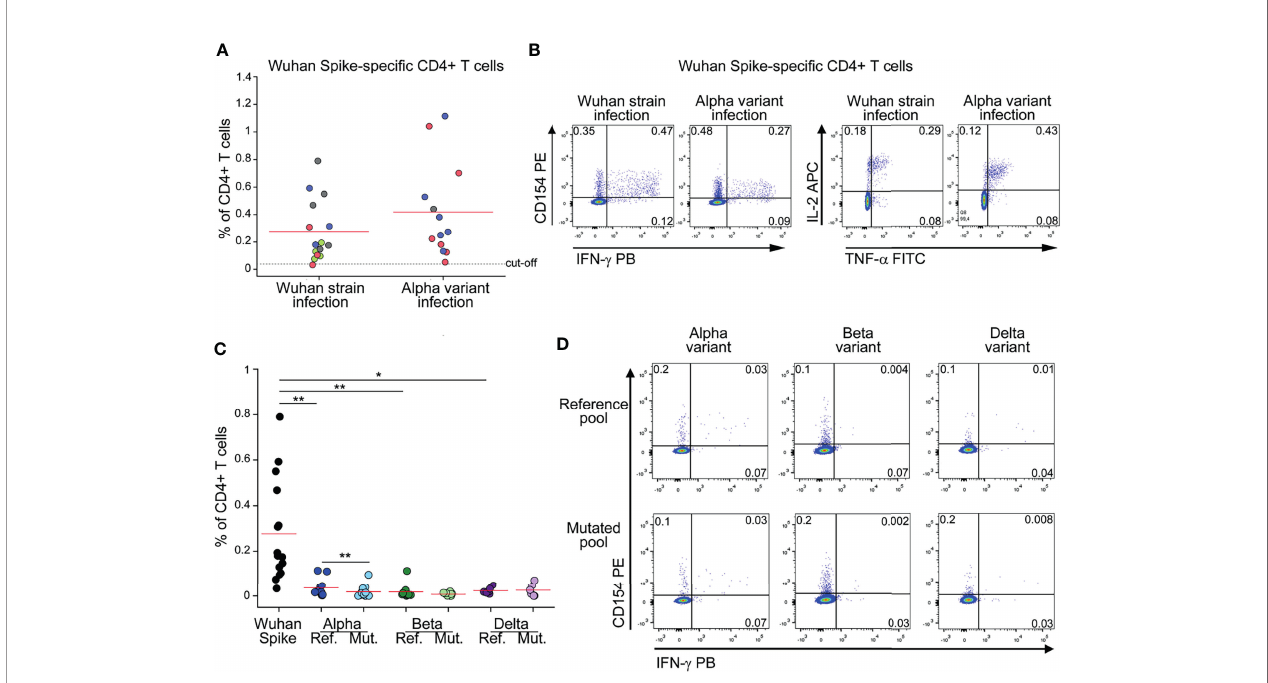
FIGURE 1 | CD4+ T cell response to Spike in subjects with previous SARS-CoV-2 infection is minimally affected by mutations occurring in Alpha, Beta and Delta variants (A) Frequency of CD4+ T cells speci fi c for Wuhan Spike protein in Wuhan strain- (15) or Alpha variant- (13) infected subjects. Mild COVID-19 patients are depicted in green, moderate in red, severe in blue, critical in gray. Representative FACS plots from one subject of each group are depicted in (B) . (C) Frequency of CD4+ T cells speci fi c for Wuhan Spike, Alpha variant reference or mutated pool, Beta variant reference or mutated pool, Delta variant reference or mutated pool in subjects with previous Wuhan strain SARS-CoV-2 infection. Representative FACS plots showing CD4+ T cells reactive to Alpha, Beta and Delta reference and mutated pools from three distinct patients are depicted in (D) . Data in (A, C) are subtracted of background, unstimulated condition. Red lines in (A, C) represent mean values. Dashed line in (A) represents cut-off value. *p < 0.05; **p < 0.01, calculated with Wilcoxon-Signed Rank